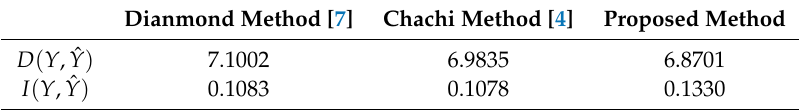
Table 7. The performance of the proposed hybrid estimation algorithm is compared with the Diamond method [7] and Chachi and Taheri method [4], as shown in Example 1. Table 7 shows that if the values of spread are repeatedly expressed with the same values, it may be more efficient to use F -transform and discriminating analysis. Table 7. The comparison of performance measures for Example